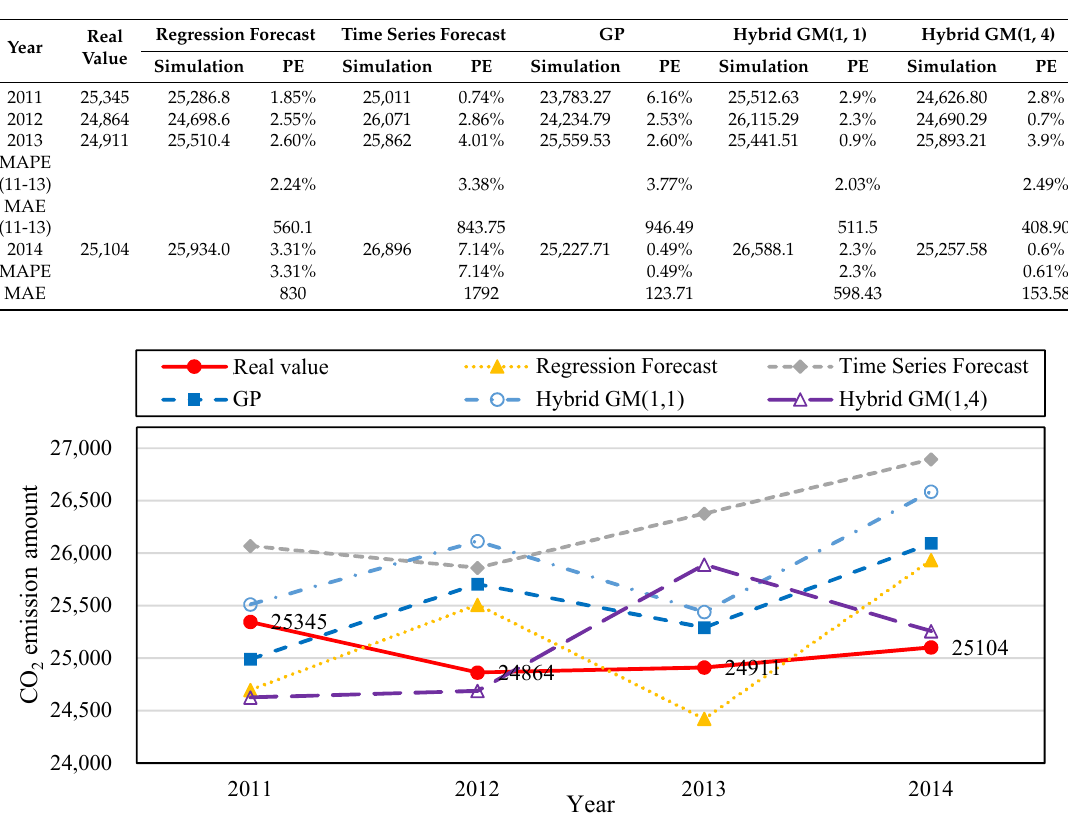
Table 12. Comprehensive comparison of forecast model trained with the data from 2011–2013 and tested with the data in 2014.